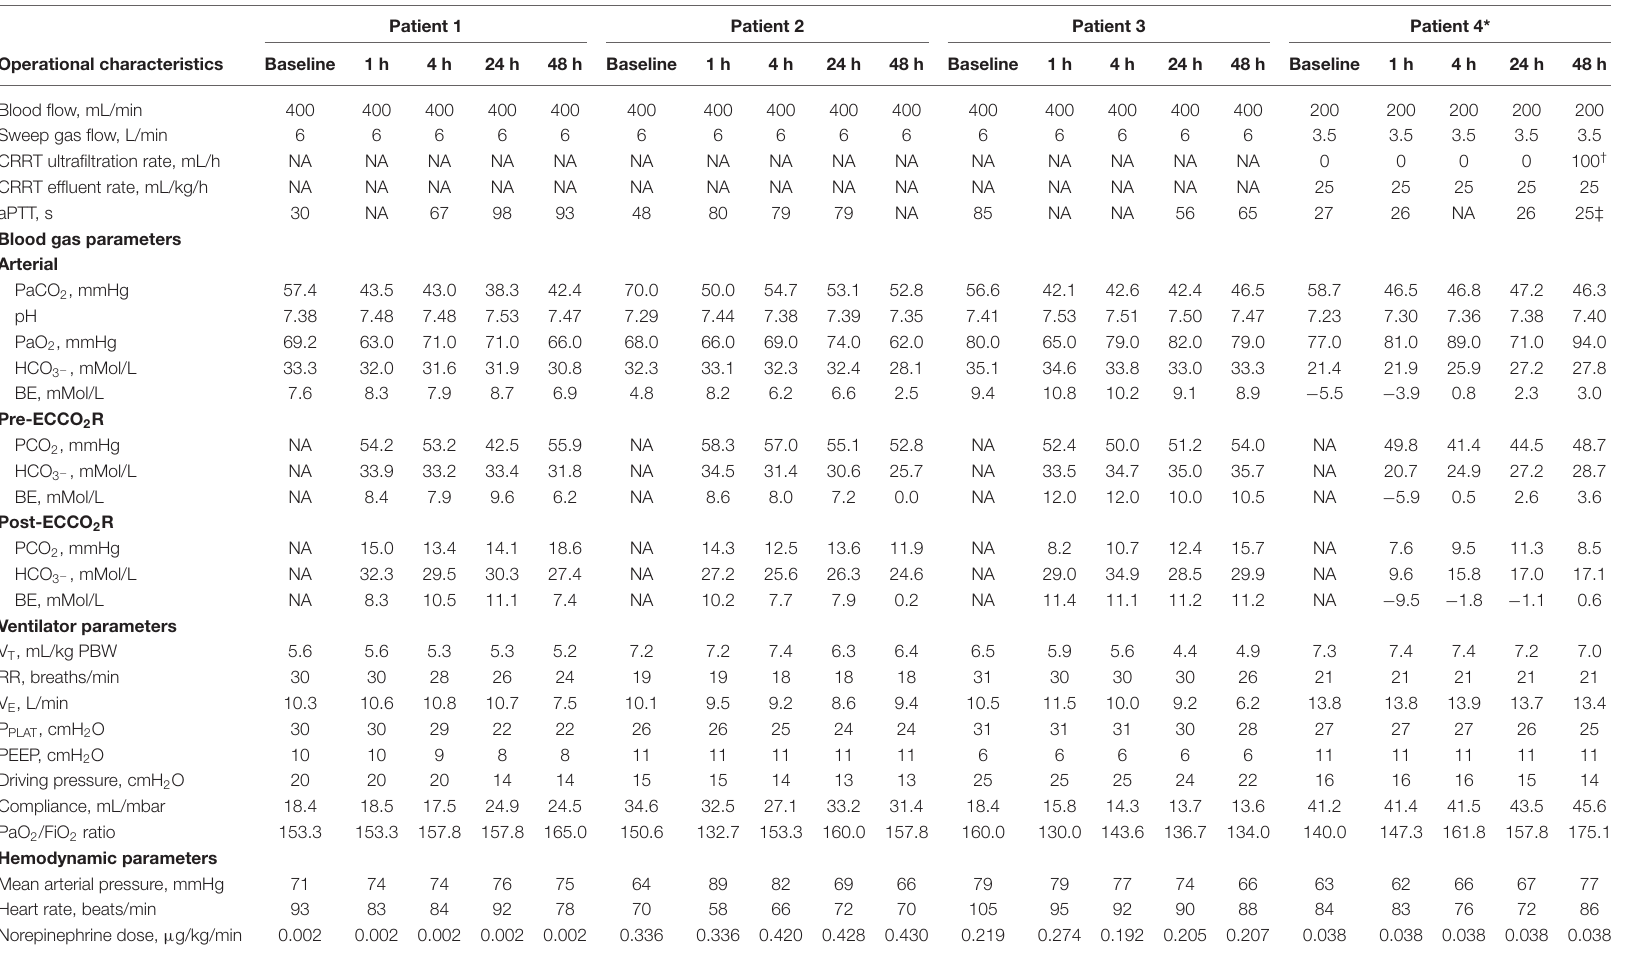
TABLE 2 | Individual time course of operational characteristics, blood gas, ventilatory, and hemodynamic parameters during ECCO 2 R. Patient 1 Patient 2 Patient 3 Patient 4* Operational